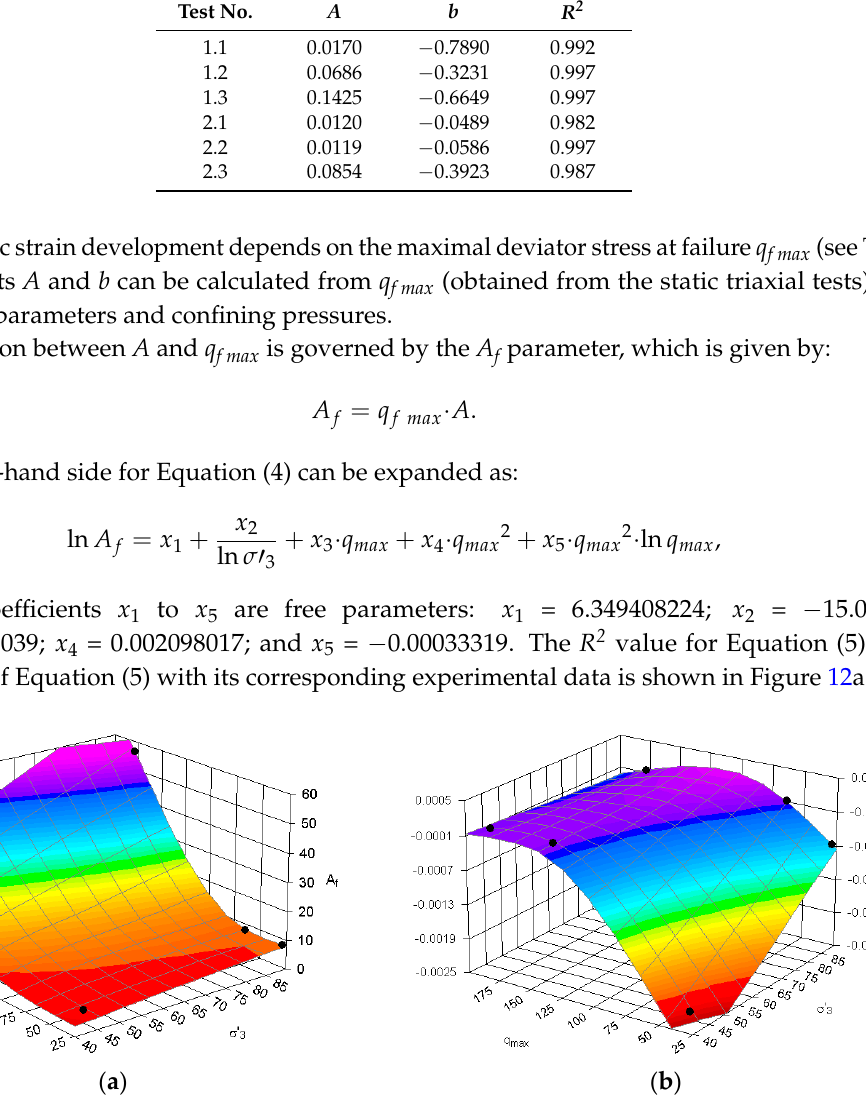
Figure 12. 3D view of ( a ) A f and ( b ) b f parameter change in various confining pressure σ ' 3 and maximal deviator stress during cyclic loading for q max values (black points stand for test results).